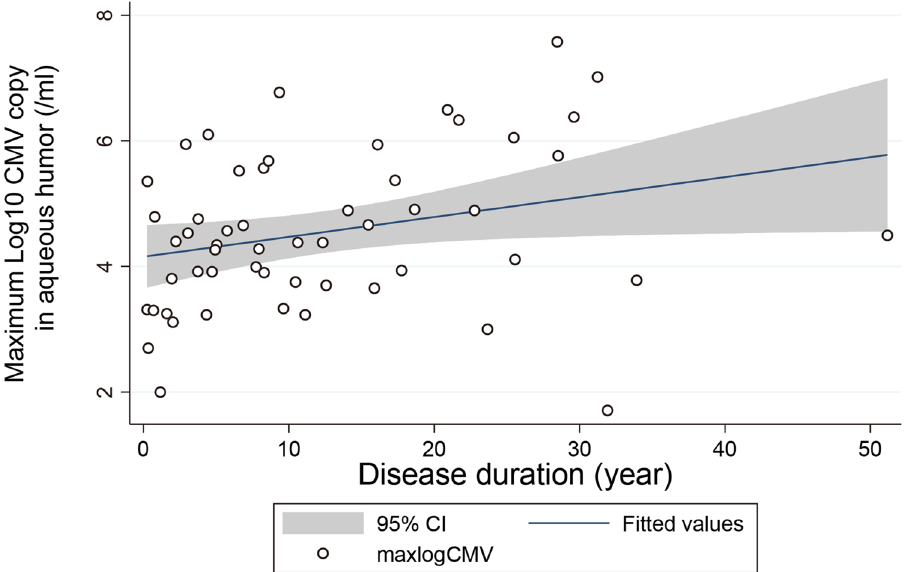
Figure 1. Association of disease duration and intraocular maximum copy numbers of the DNA of CMV in the anterior segment of CMV infected eyes. Fifty-five patients with CMV anterior segment infection were assessed for copy numbers of the DNAs of CMV in the aqueous humor. Maximum CMV copy numbers during the follow-up period was correlated with longer disease duration. Spearman correlation analysis, ρ = 0.32, P = 0.01.